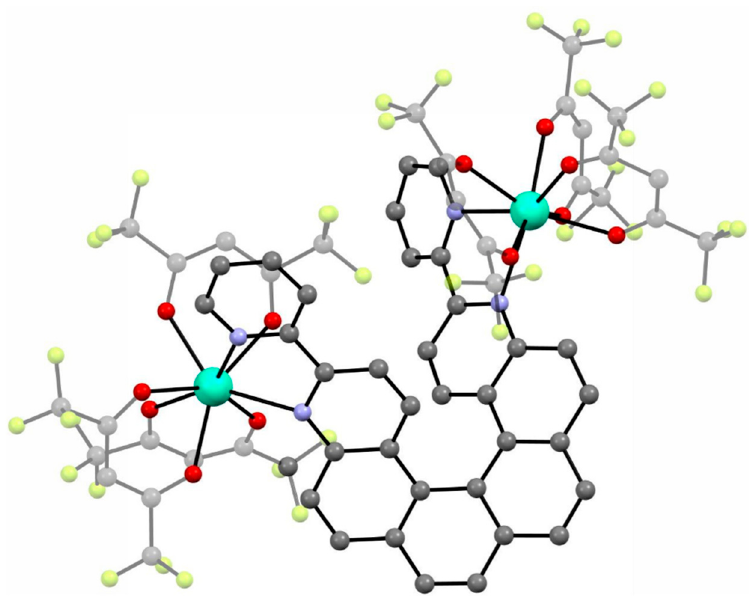
Figure 4. The crystal structure of [Dy 2 (hfac) 6 (L2)] ( 3 ). Dy—teal, O—red, C—gray, N—blue, F— bright yellow. [Yb 2 (hfac) 6 (L2)] ⋅ C 6 H 14 ( 4 ) shows very similar molecular geometry but different crystal yellow. [Yb 2 (hfac) 6 (L2)] · C 6 H 14 ( 4 ) shows very similar molecular geometry but different crystal packing.